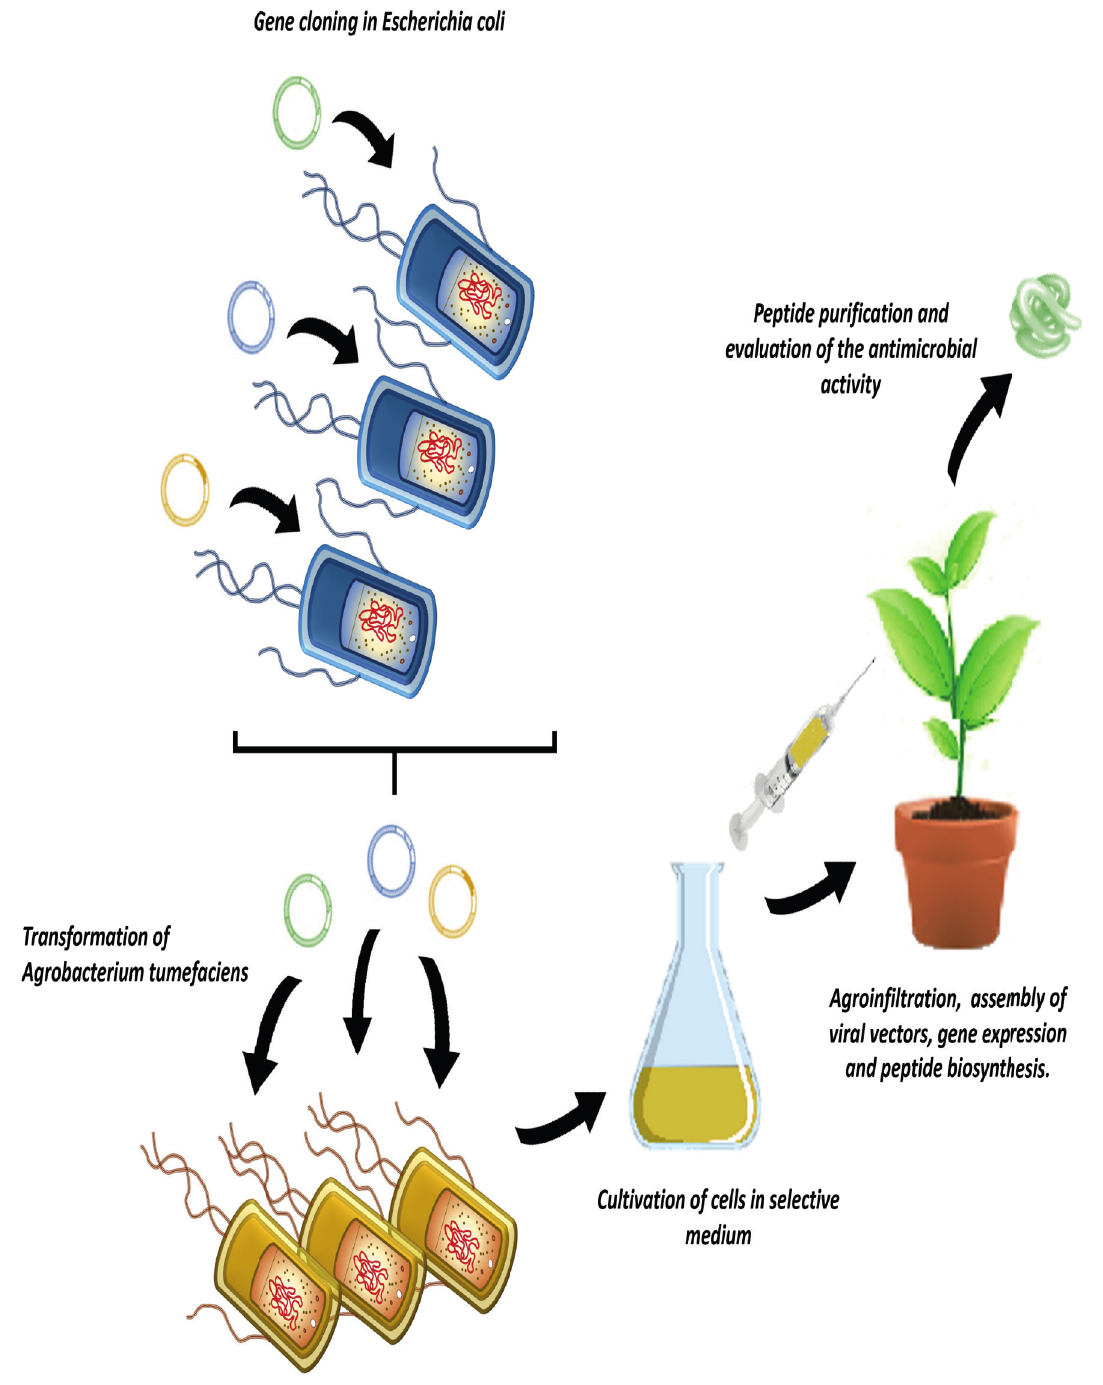
Figure 1 – Agroinfi ltration method for the large-scale biosynthesis of recombinant AMPs. After gene cloning using E. coli cells, pro-vectors carrying the 3`extremity of the expression cassette (green vector), the 5`extremity of the expression cassette (blue vector) and the gene that codifi es the integrase for the extremities recombination (yellow vector) are inserted in A. tumefaciens cells, followed by cultivation in LB medium. The bacterial culture is then injected in the downside of N. benthamiana leaves. After 5 to 8 days, yields of recombinant AMPs can be obtained from harvested leaves after extraction and purifi